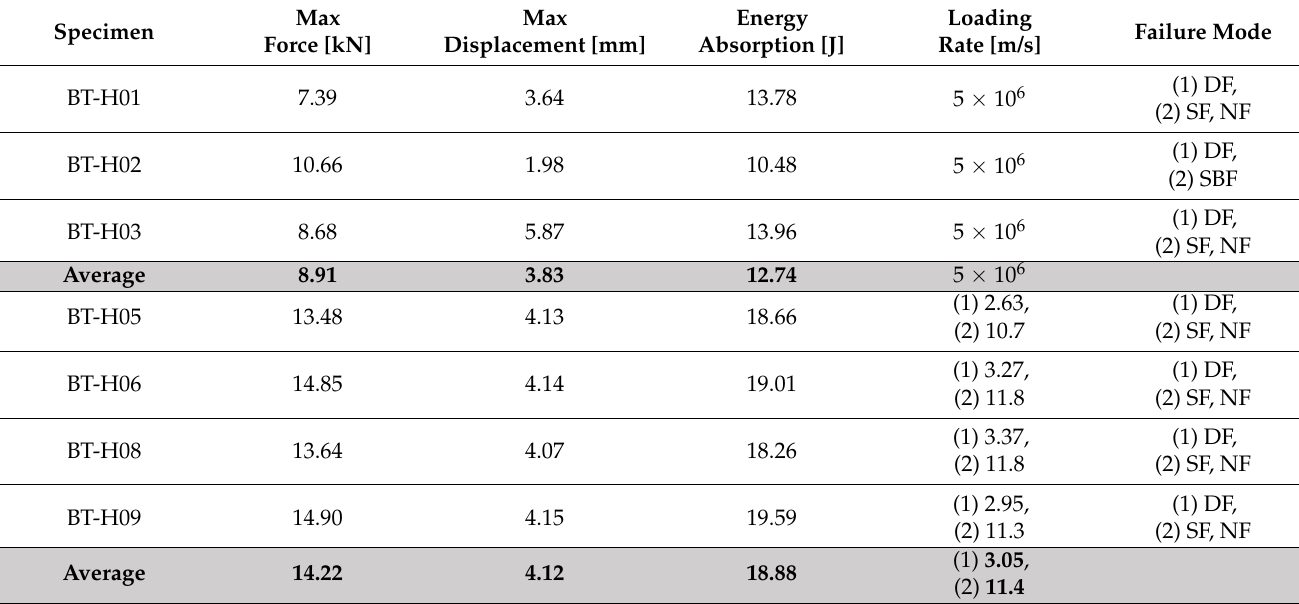
Figure 15. Force–displacement of the multi-material bonded/bolted joints (QS—quasi-static and Dy—high-rate). Table 3. Results of the multi-material bonded/bolted joints (DF—delamination failure, SBF—bolt shear failure, NF—net tension failure, SF—shear-out failure, and TSF—tension and shear-out failure).